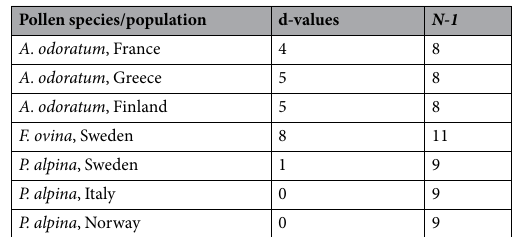
Table 3. d-values obtained using MANOVA on the score values of PC1 to PC10 on the data set of each population and number of theoretically possible groups (N-1) that could form based on the number of genotypes N that are present in the data of each population, assuming genotype-based cluster formation. The d-values indicate the dimensionality of the multivariate vector of the groups for each data